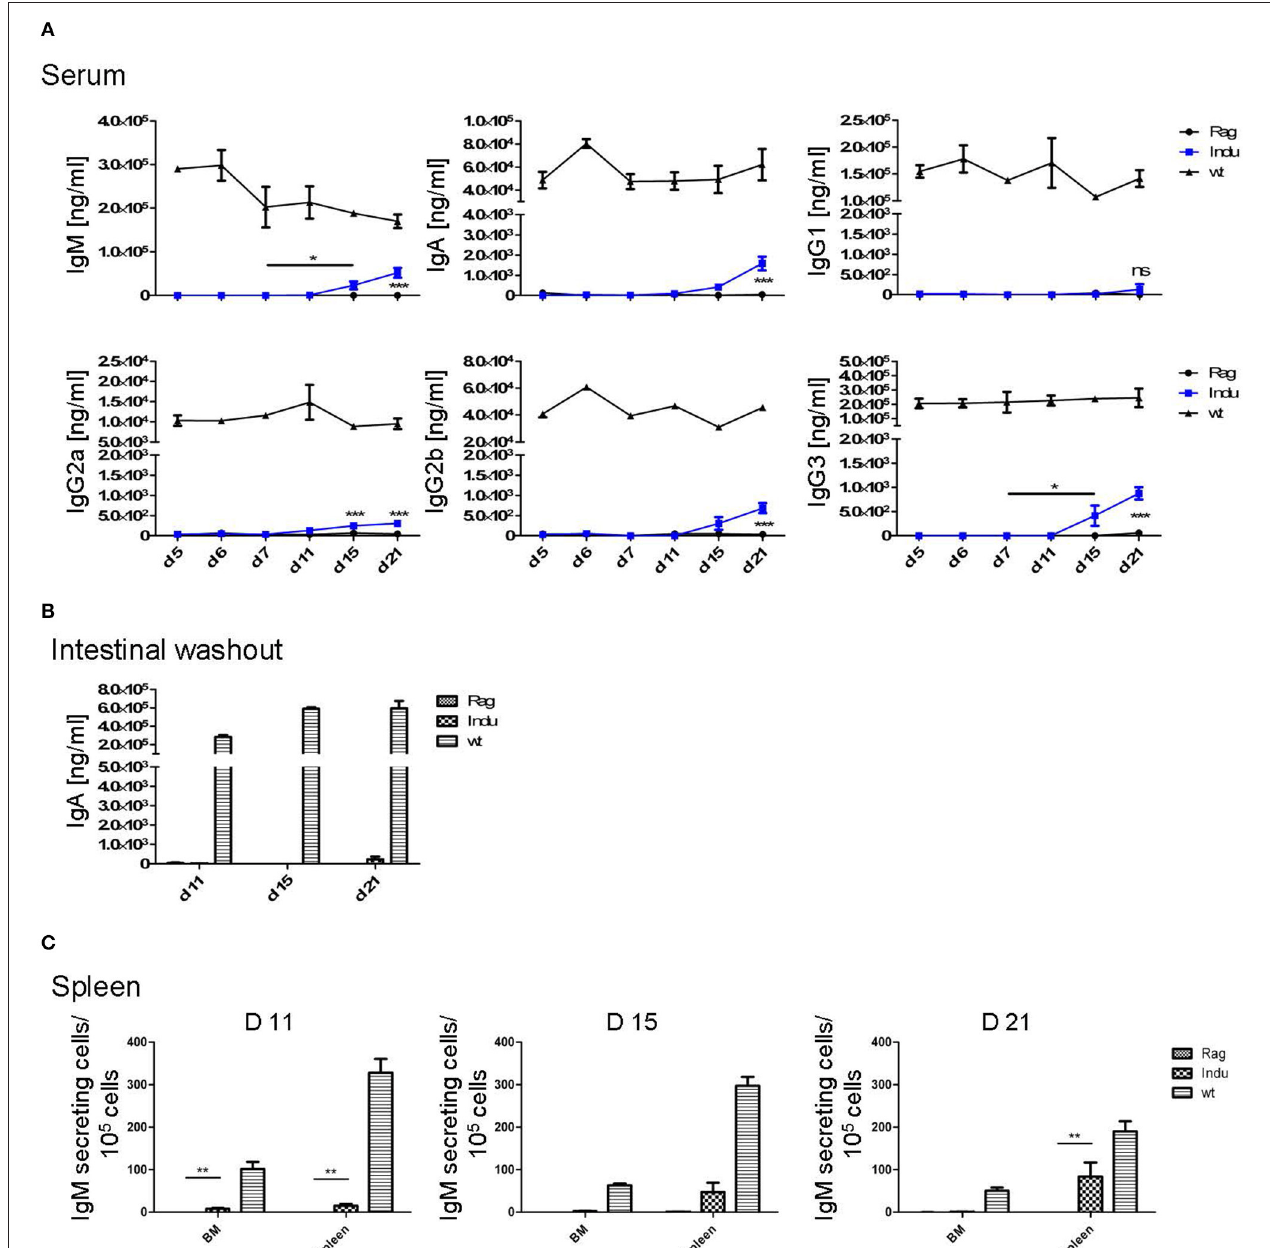
FIGURE 3 | Induction of B lymphopoiesis in B-Indu-Rag1 mice correlates with increased Ig concentrations over time. Ig classes (IgM, IgA, IgG) and IgG subclasses (1, 2a, 2b, 3) in (A) serum and (B) intestinal washout of 3 mice per group were quantified by ELISA (ng/ml) at different time points after initiation of the experiment, as indicated. Blue squares: TAM-treated B-Indu-Rag1 mice; black circles: Rag1 − / − ; mice; black triangles: Wt mice. (C) Number of IgM-secreting cells among 10 5 total cells from BM and spleen of TAM-treated B-Indu-Rag1 mice, as revealed by ELISPOT at indicated time points after initiation of the experiment. Data from Rag1 − / − and Wt mice are included for comparison (2–3 mice per group). (A–C) , mean values ± SEM; asterisks in graphs indicate the level of significance (see methods for details). The experiments were carried out at least